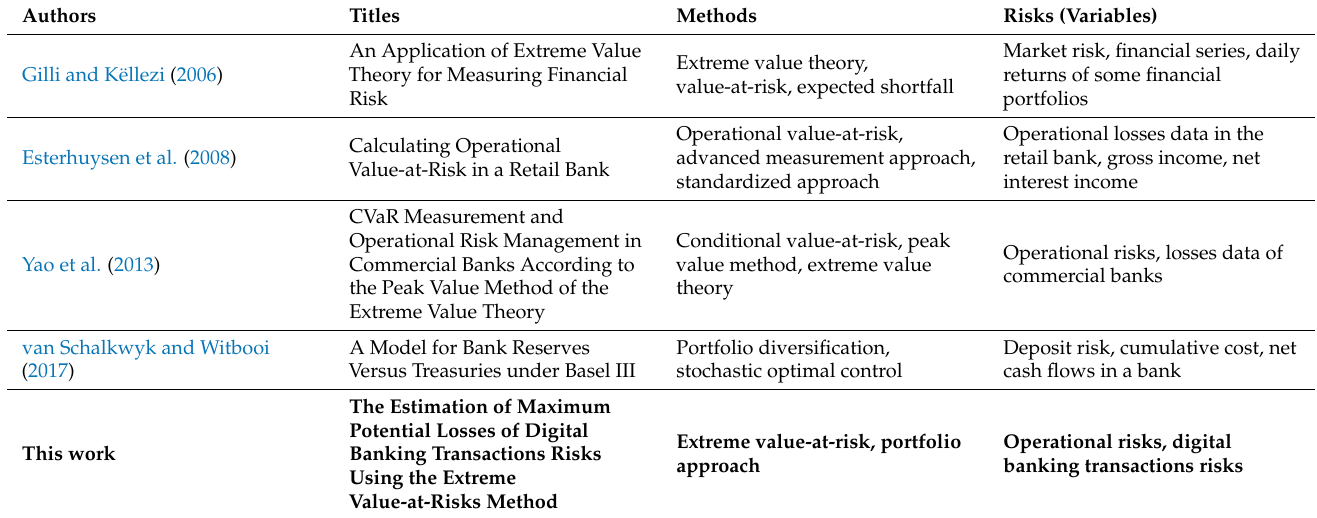
Table 1. Research